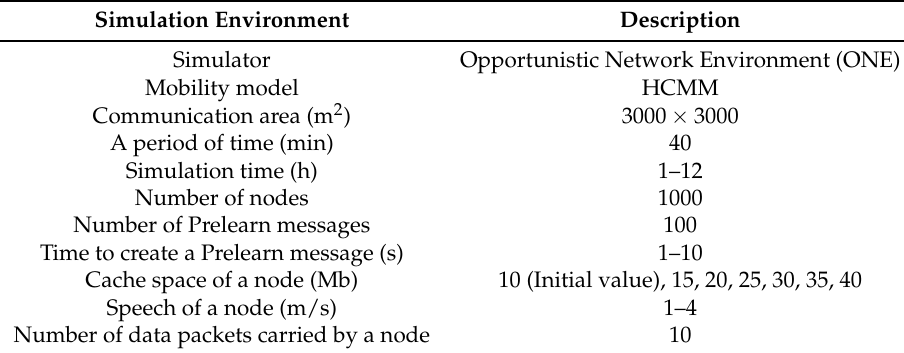
Table 1. The simulation settings for Predict and Forward